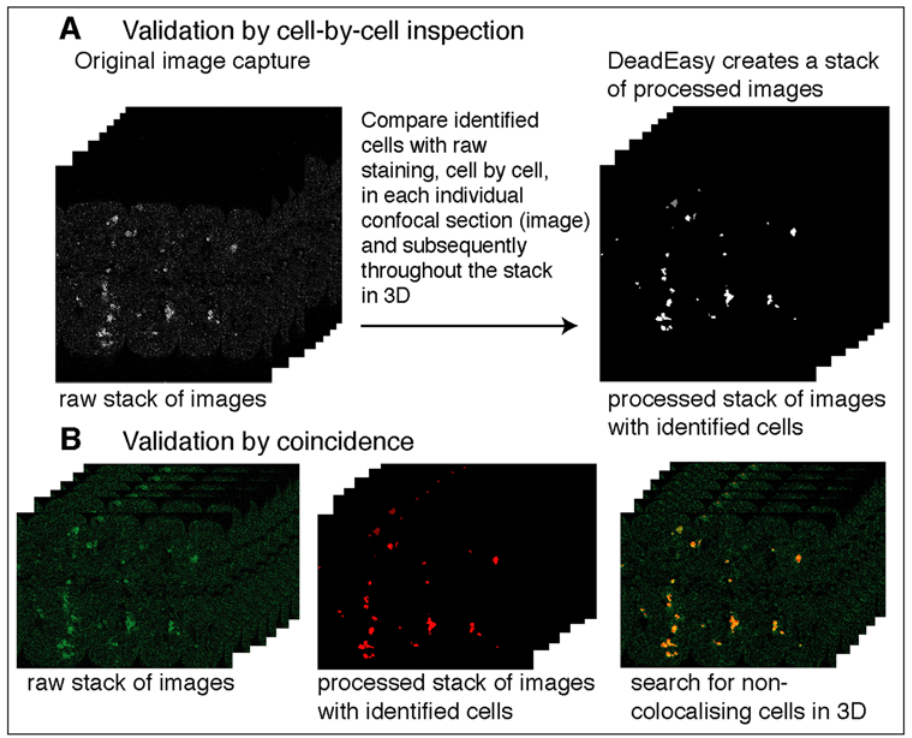
Figure 5. Validation of DeadEasy Caspase. (A) During processing, DeadEasy creates a second stack of confocal images reproducing the identified objects in locations that correspond to those of cells in the original raw stack. By placing the mouse over each of the objects, an identifying number is revealed (as shown in Figure 2), showing whether a cell is counted appropriately. We compared one cell at a time in this way through multiple stacks. (B) Using a second validation method, a merged stack can be created from the raw images (green) and the processed images with the identified objects (red). Colocalising cells in the merged stack (yellow) indicate the identified cells, green cells are false negatives and red cells are false positives.